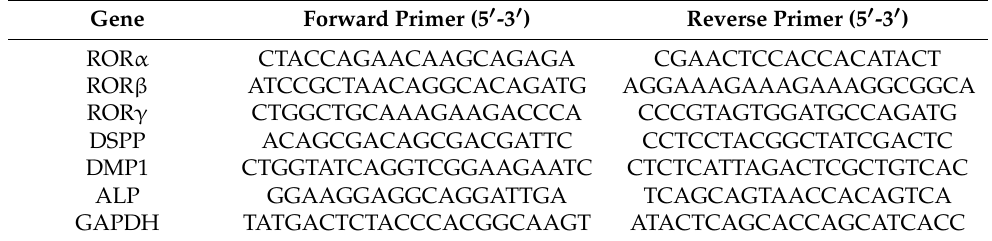
Table 1. Specific primers for polymerase chain reaction